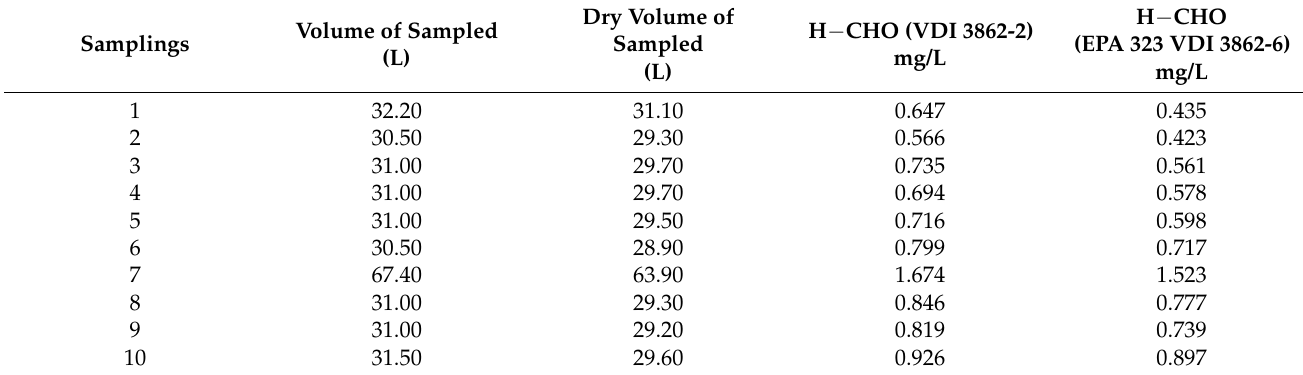
Table 11. The results obtained by Lab. APPA Trento (sampling #1 and #2) from sampling in acid solution, washing, and analysis with HPLC are reported. The addition of DNPH was made directly at the end of the sampling.